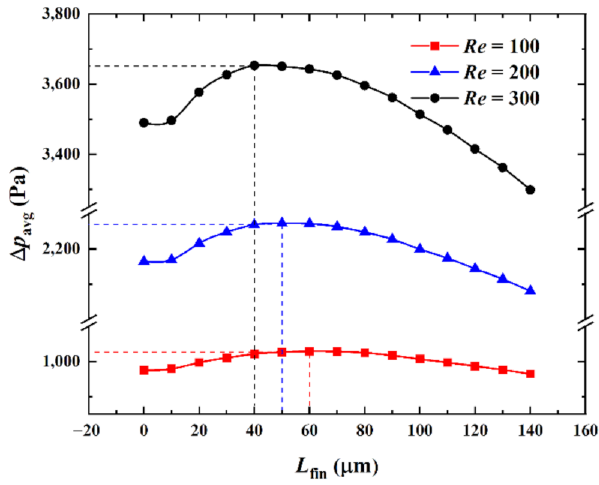
Figure 12. Effect of Re on ∆ p avg versus L fin